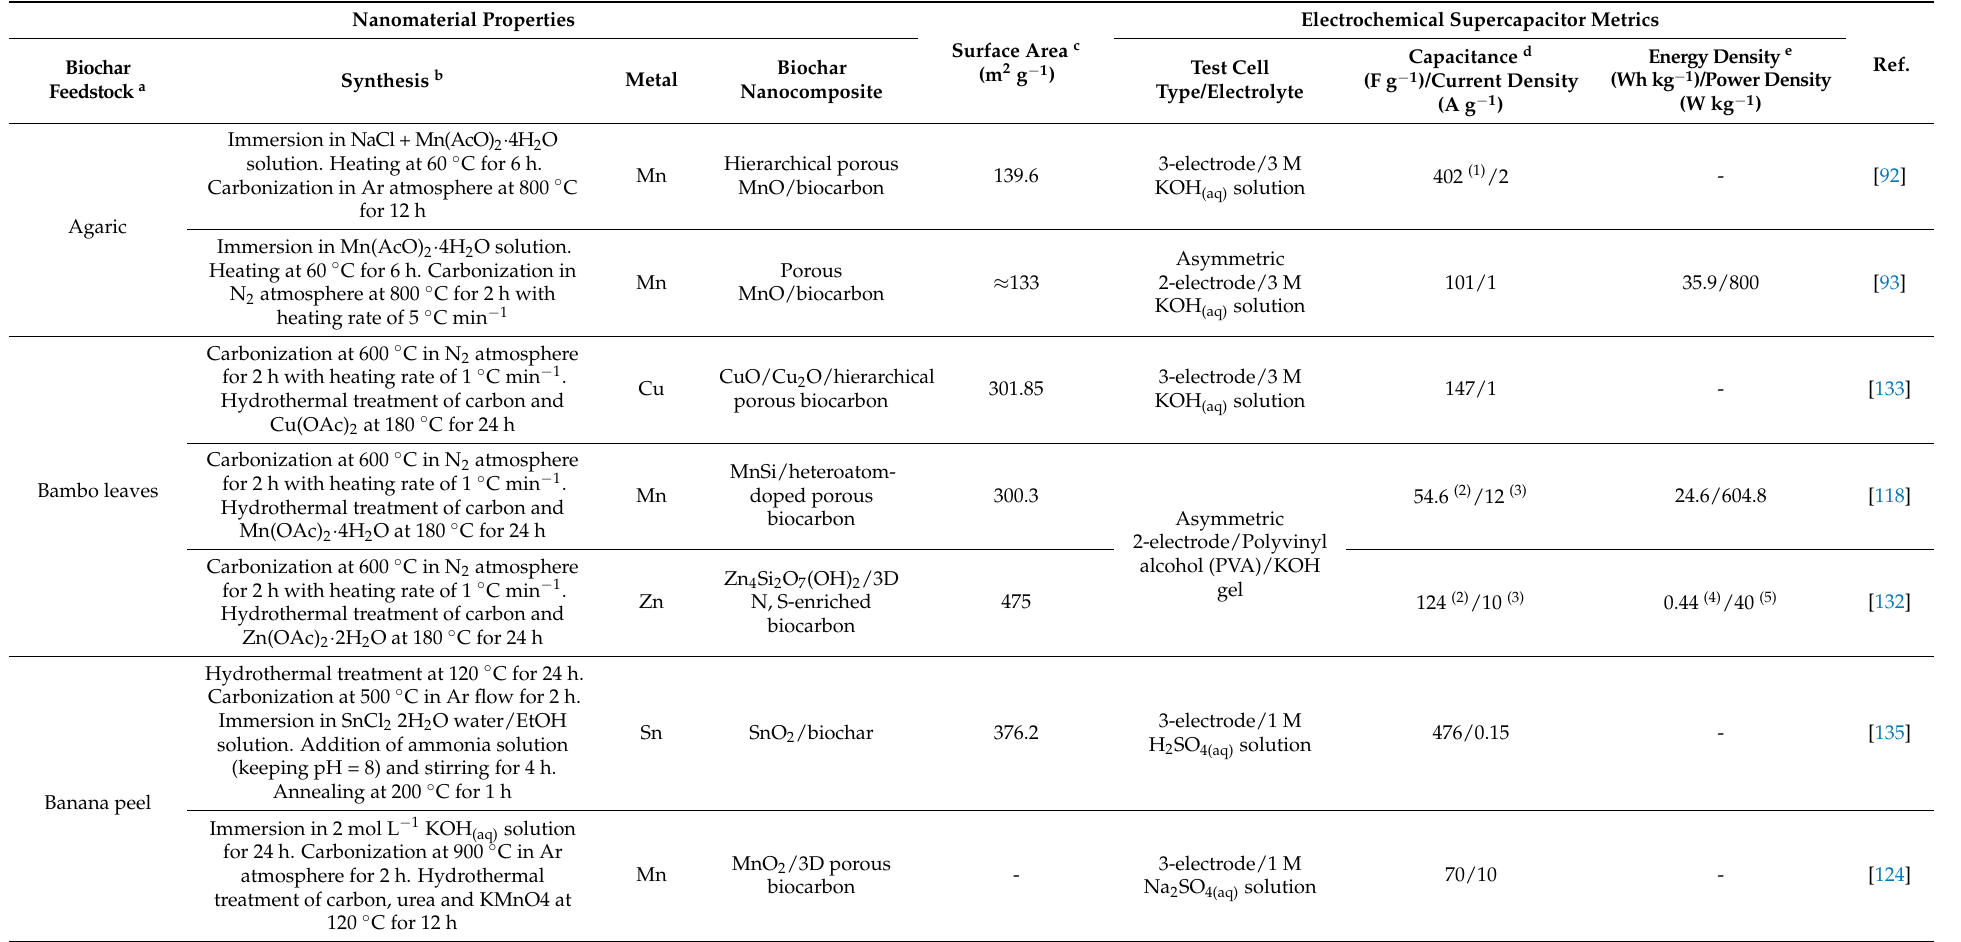
Table 6. Metal-supported biochar-based nanocomposites for supercapacitor